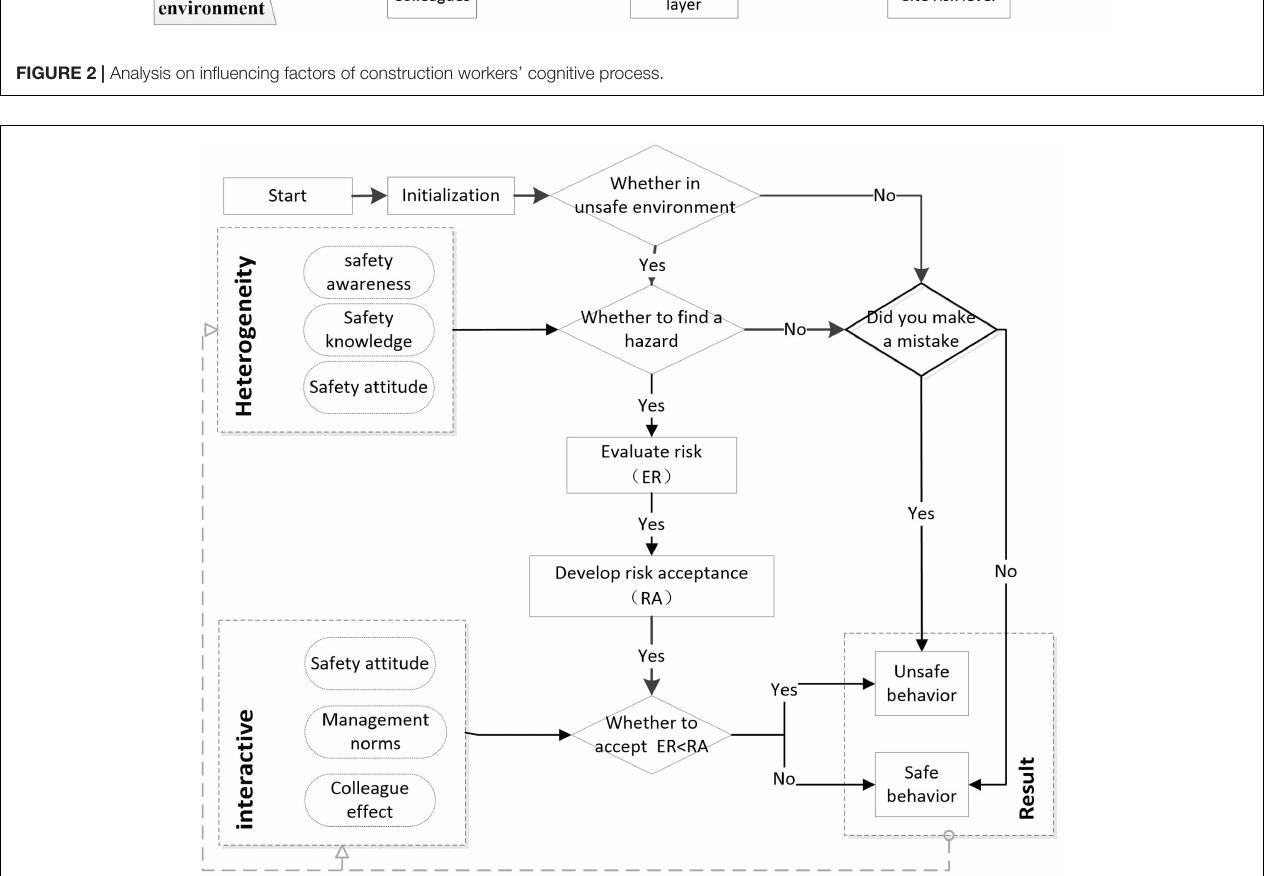
FIGURE 3 | Agent behavior